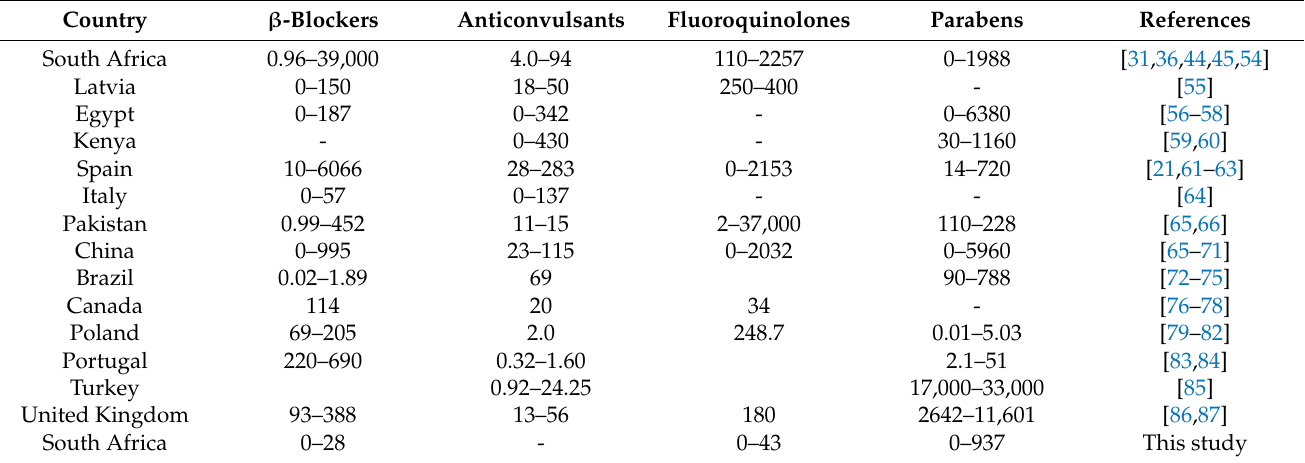
Table 5. Global concentrations (ng L − 1 ) of β -blockers and anticonvulsants, fluoroquinolones and parabens in environmen- tal